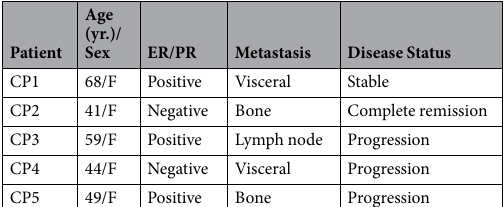
Table 1. Clinical characteristics and the state of cancer progression at the time of blood extraction. F, Female; ER, estrogen receptor; PR, progesterone